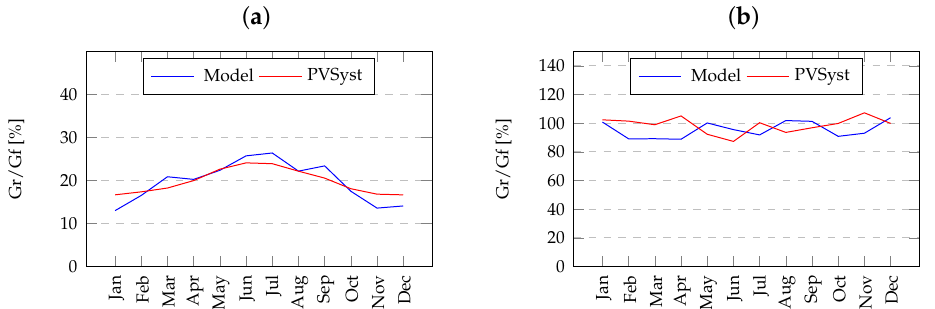
Figure 11. Estimated model comparison vs. the PVSyst Gr/Gf % gain from Jan to Dec for the ( a ) tilted SN orientation and ( b ) vertical EW orientation, Location—Kharagpur.